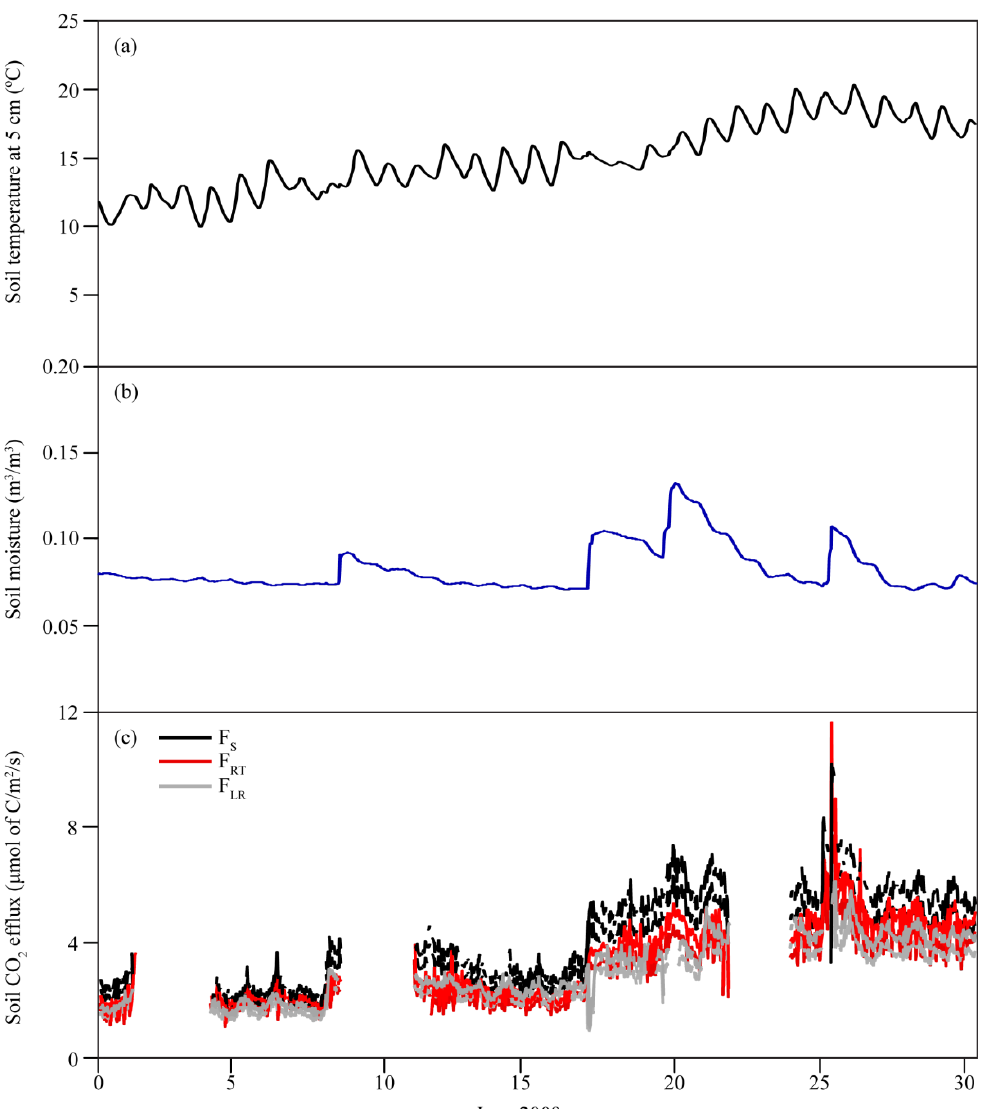
average patterns from pre- (solid line) and post- (dotted line) harvesting event in 2012 are compared with the same months that have similar average temperature and total precipitation.